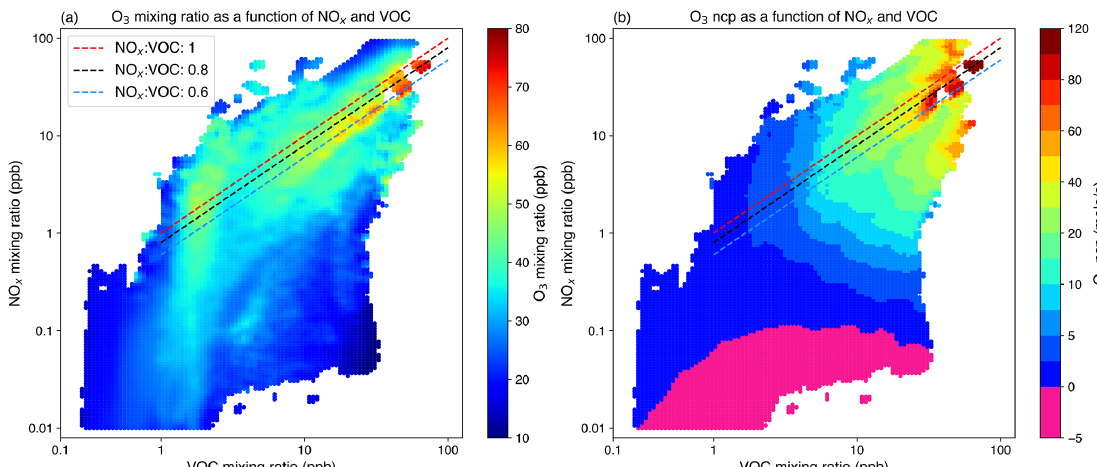
Figure 6. Surface O 3 mixing ratios (a) and O 3 net chemical production (ncp) rates (b) as a function of monthly mean NO x and VOC mixing ratios. Monthly mean data for all months and all scenarios are used. The straight lines show the approximate thresholds of NO x / VOC to distinguish VOC-limited (above the line) and NO x -limited (below the line)